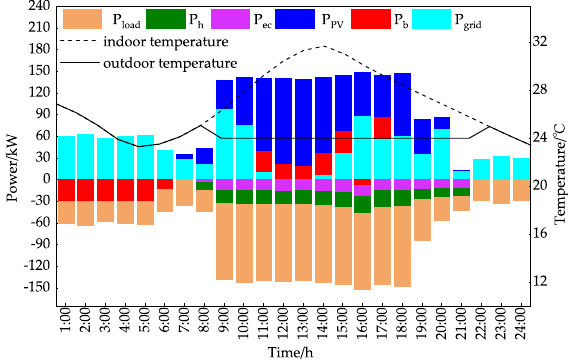
Figure 5. The optimal scheduling results when virtual energy storage (VES) is not considered.